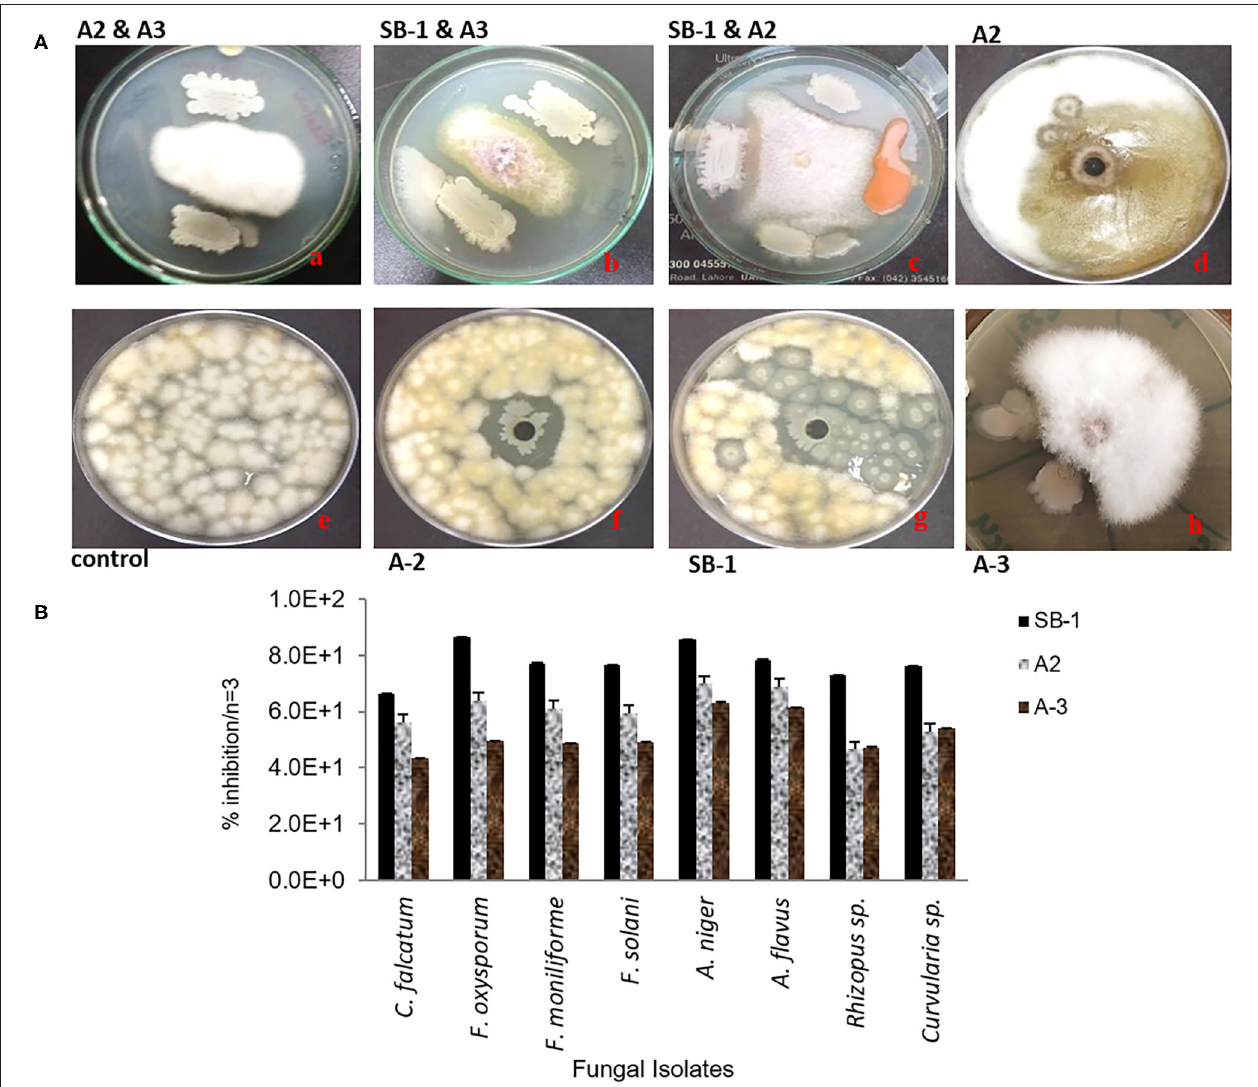
FIGURE 1 | Antifungal dual plate-assay of Bacillus spp. strains with plant-pathogenic fungi; F. oxysporum, F. moniliforme, and F. solani . (A) percentage inhibition of fungal plant pathogens by Bacillus spp. with agar well-diffusion assay (B) .